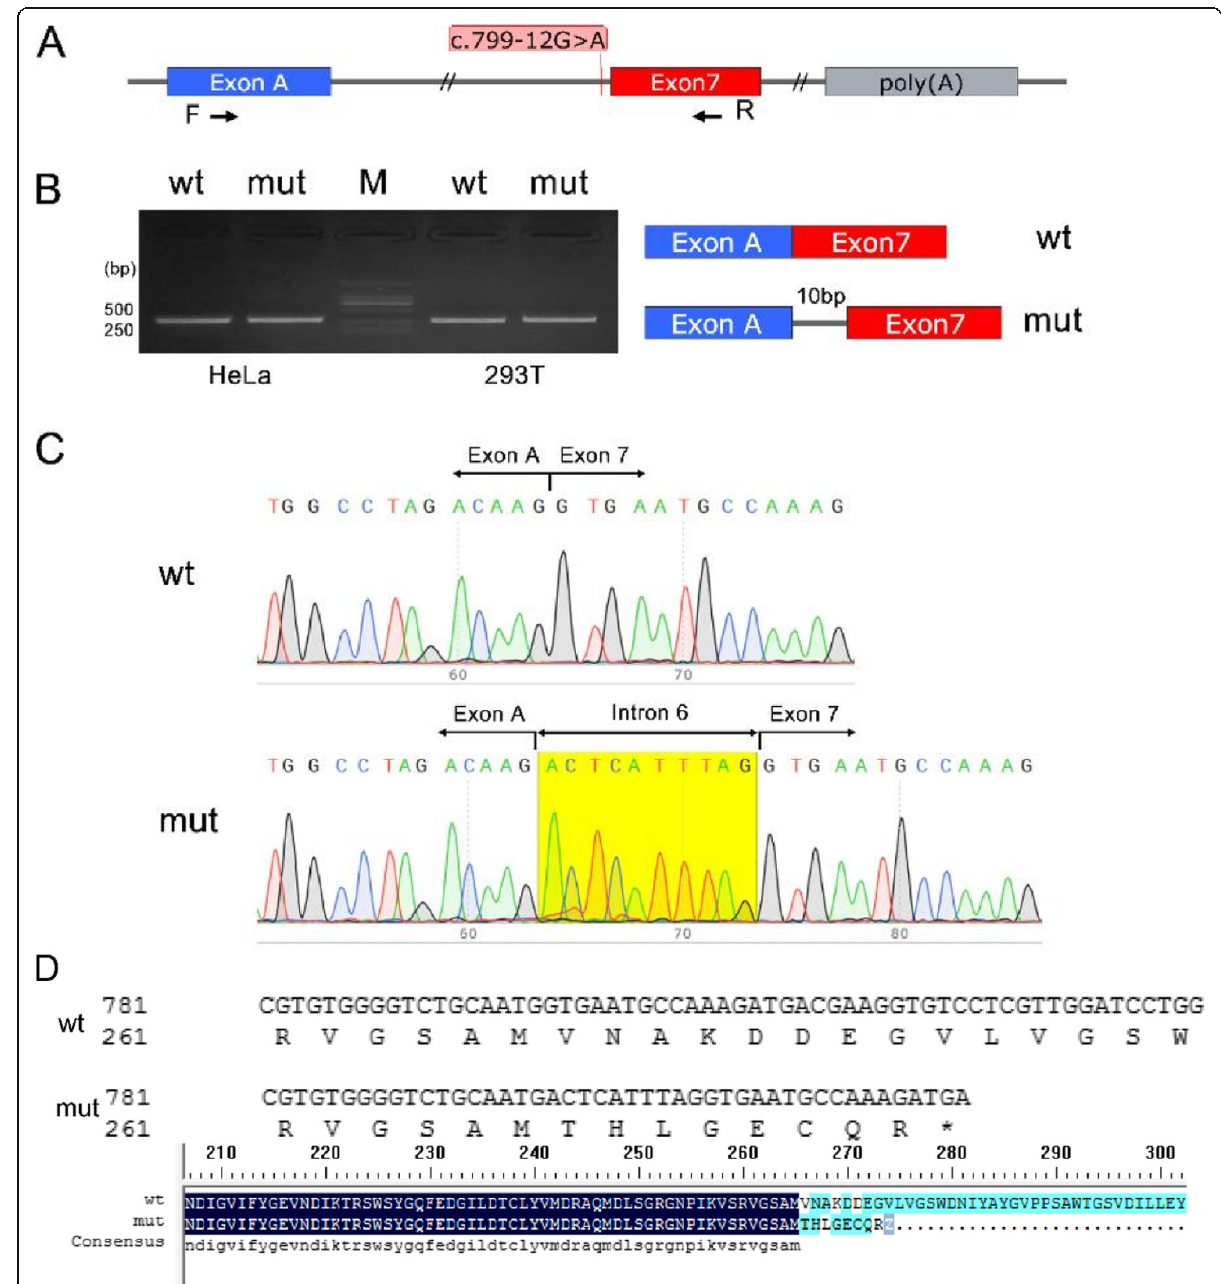
Fig. 3 Analysis of the c.799 – 12 G > A mutation using minigene construct. A , the F13A1 gene fragment selected for minigene. The position of mutation site c.799-12G > A and fragment containing exon 7 and its adjacent intron 6 are indicated. B , C analysis of mRNA from transfected Hela and 293 T cells via real-time polymerase chain reaction and direct sequencing. The expressed WT and mutant minigenes mRNA was analyzed via agarose gel electrophoresis and direct sequencing. D , The amino acid sequence of wt and mutated